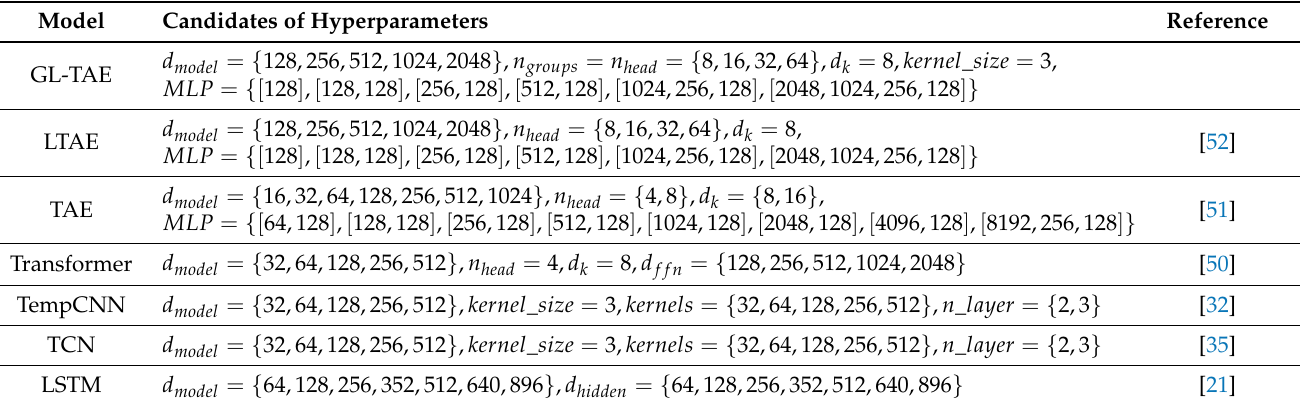
Table 3. Candidates of hyperparameters of different